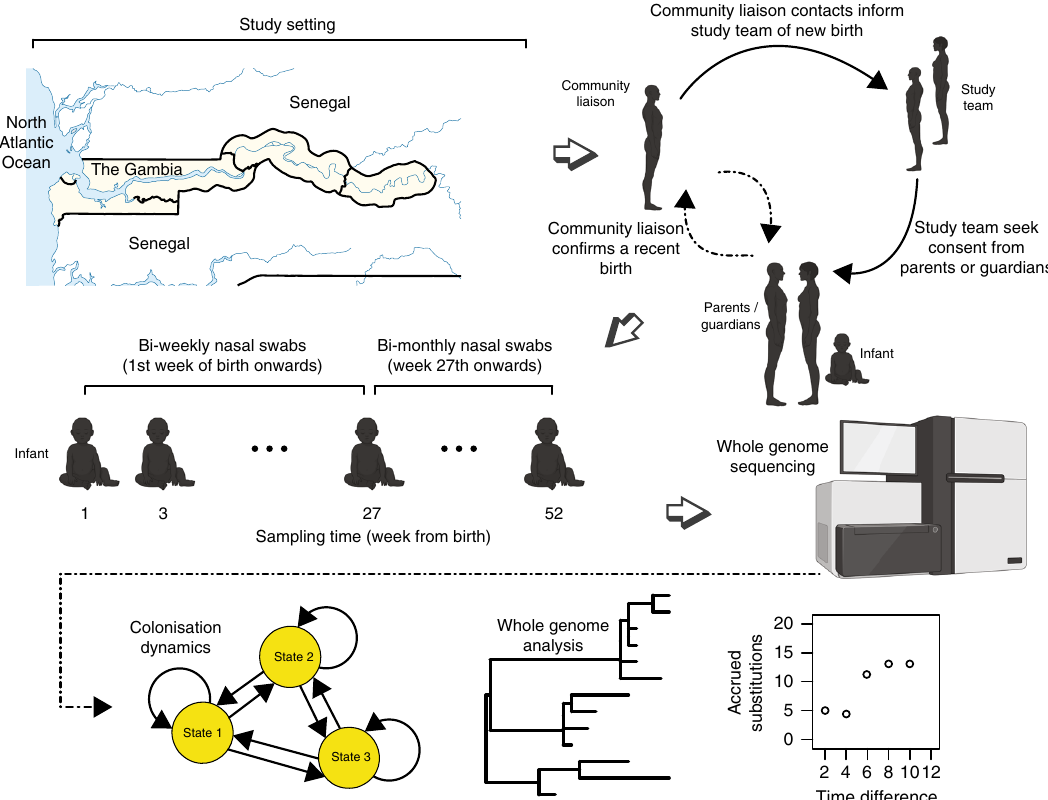
Fig. 1 Schematic of the study design and analysis work fl ow. The newly born babies were recruited into the study at birth and nasopharyngeal swabs were taken with the fi rst week after birth and every two weeks until six months and then after every month until they were one year old at which sampling was stopped. The analysis of these longitudinal data involved fi tting multi-state and other models to determine colonisation dynamics in the babies during the fi rst year of life and whole-genome analysis to assess the within-host genetic diversity, recombination and mutation rate of the isolates. The map of The Gambia was generated by the authors in R software using ggmap v3.0.0 package (https://cran.r-project.org/web/packages/ggmap/). The images of the infants and adults, and the DNA sequencing machine were created with BioRender (https://biorender.com/) with permission to